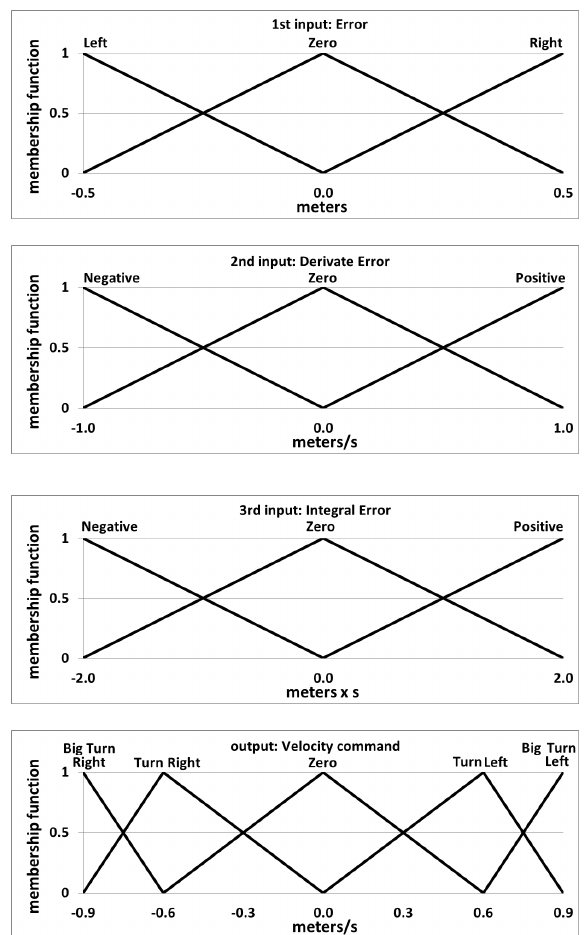
Figure 16. Final design of the variables of the fuzzy controller after the manual tuning process in the virtual environment (V-REP).